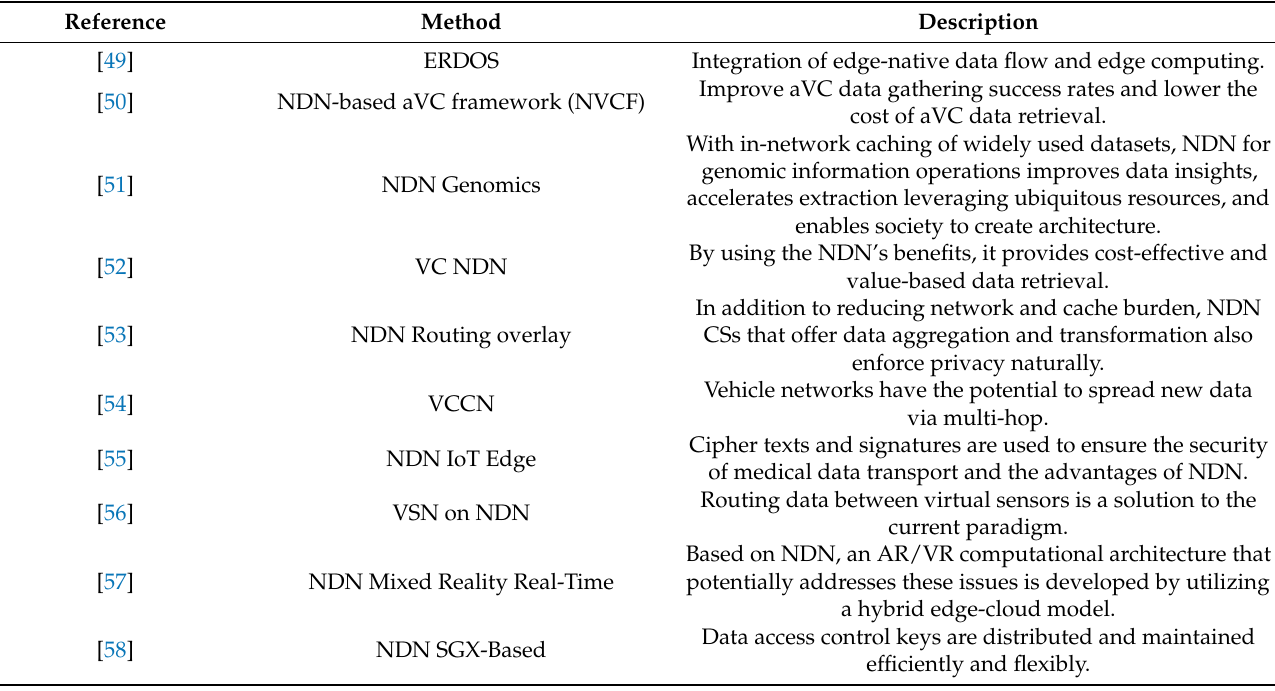
Table 1. NDN cloud